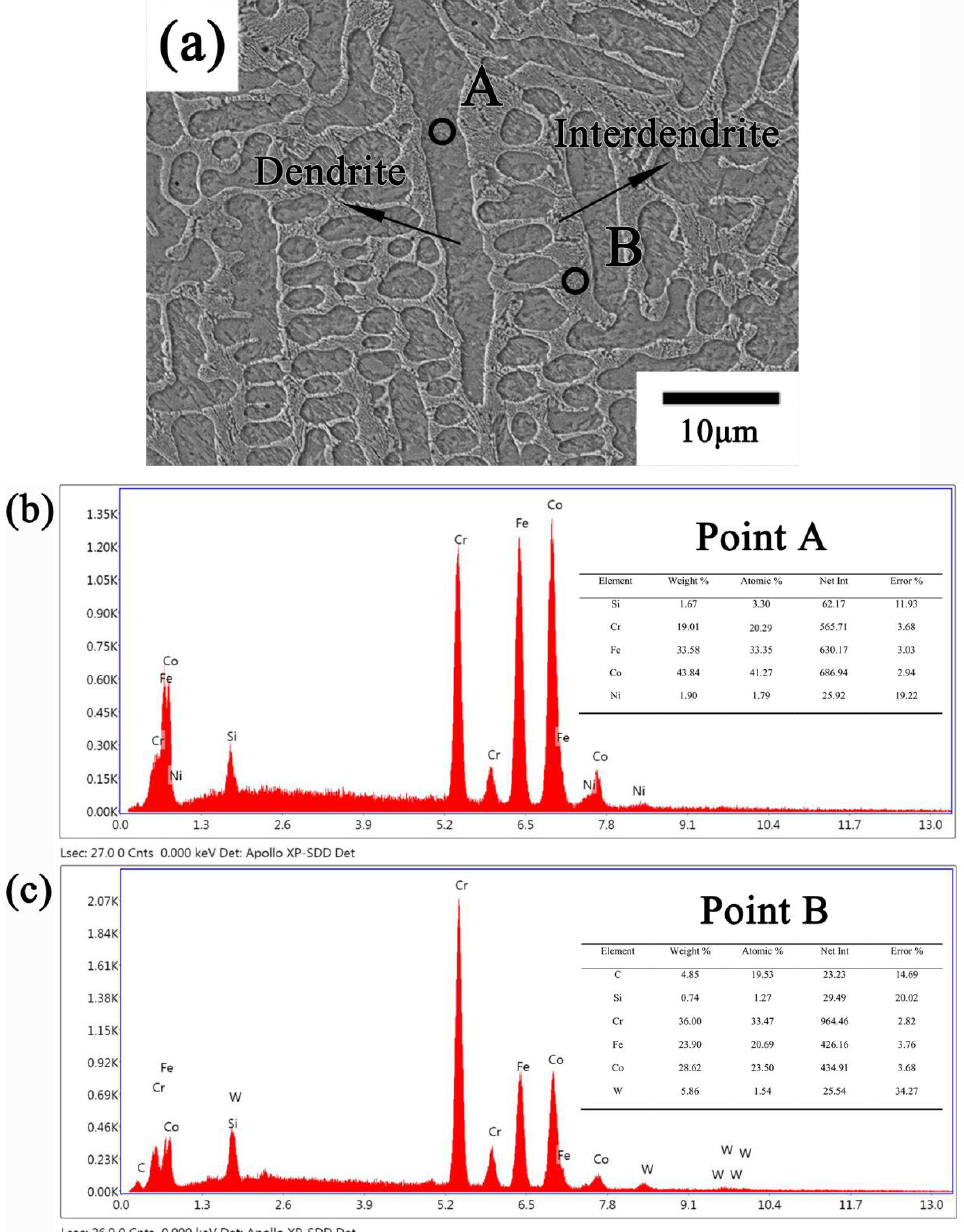
Figure 4. SEM–EDX analysis of the Co-based alloy cladding layer: ( a ) microstructural morphology at the top of the coating; ( b ) point scanning at point A; ( c ) point scanning at point B. During the laser cladding process, the powder and the surface of the H13 steel sub- strate were melted under a high-energy input and then rapidly cooled, resulting in a diverse solidification microstructure in the molten pool. There are two important factors that significantly influence the ultimate solidification microstructure: the temperature gra- dient (G) and the solidification rate (R). Moreover, the value of the G/R ratio in the molten pool is a key factor in the final microstructural composition, according to the